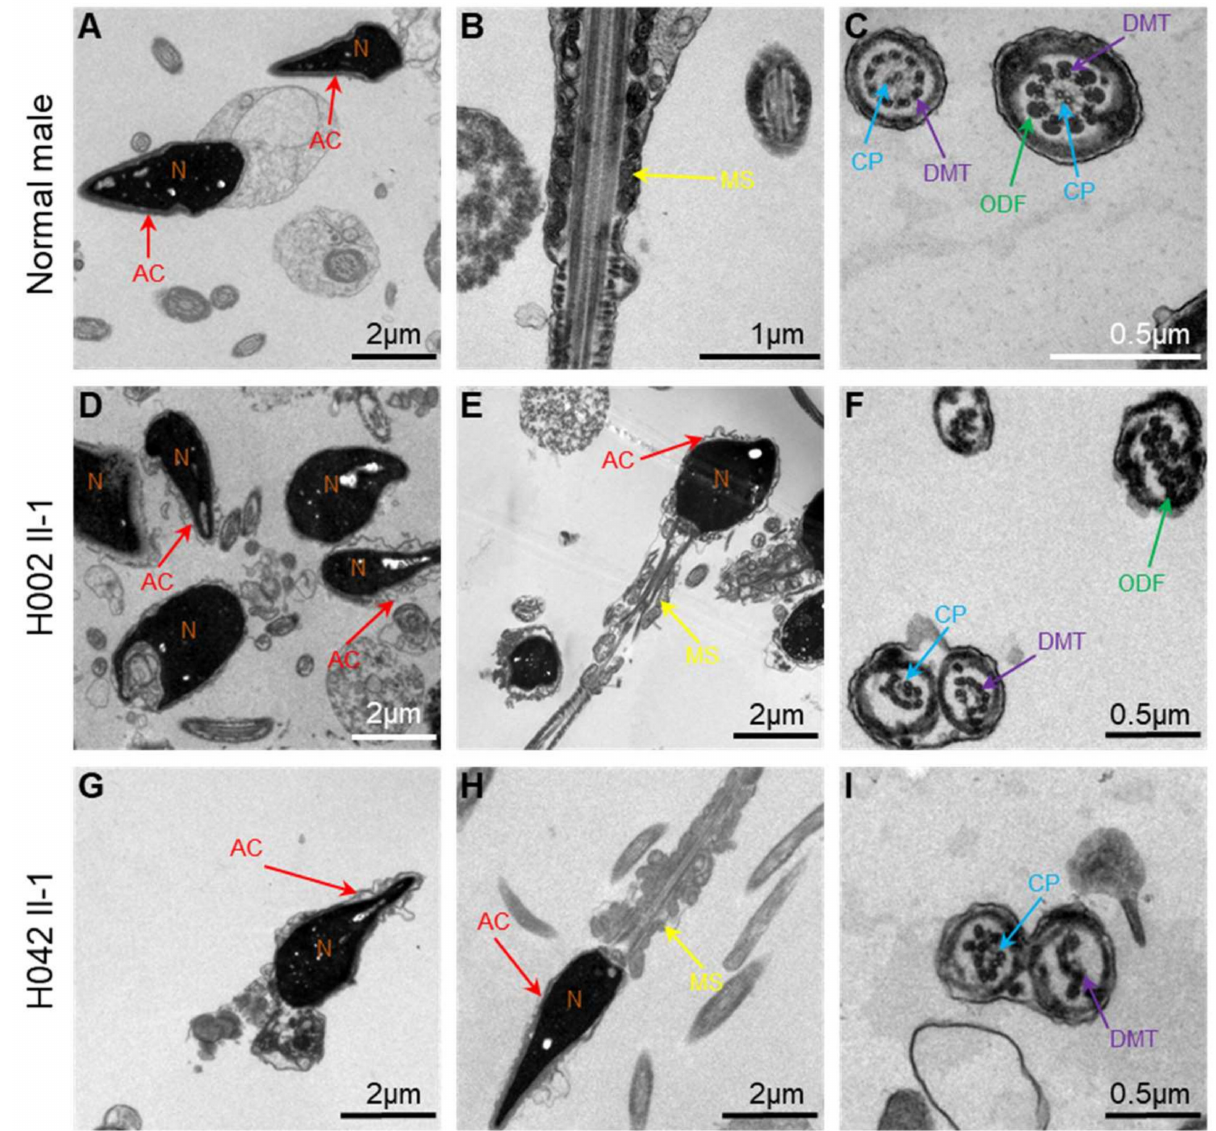
Figure 6. TEM analyses of sperm cells from a normal male control and men harboring hemizygous USP26 variants. In the cross-sections of the sperm cells from a control individual, acrosomes can be seen tightly attached to the nucleus ( A ), the mitochondrial sheath is regularly distributed in the midpiece of the sperm flagella ( B ), and typical “9 + 2” microtubule structures are clearly observed ( C ). Cross-sections of the spermatozoa from men harboring hemizygous USP26 variants revealed various abnormal ultrastructures of sperm heads and flagella, including partial defects or loss of the acrosome ( D , E , G , H ), disorganization of the mitochondrial sheath and peripheral microtubules ( E , F , H , I ), and a lack of the central pair of microtubules or other peri-axonemal structures ( F , I ). Abbreviations: CP, central pair of microtubules (blue arrows); DMT, peripheral microtubule doublet (purple arrows); ODF, outer dense fiber (green arrows); MS, mitochondrial sheath (yellow arrows); AC, acrosome (red arrows); N, nucleus (orange